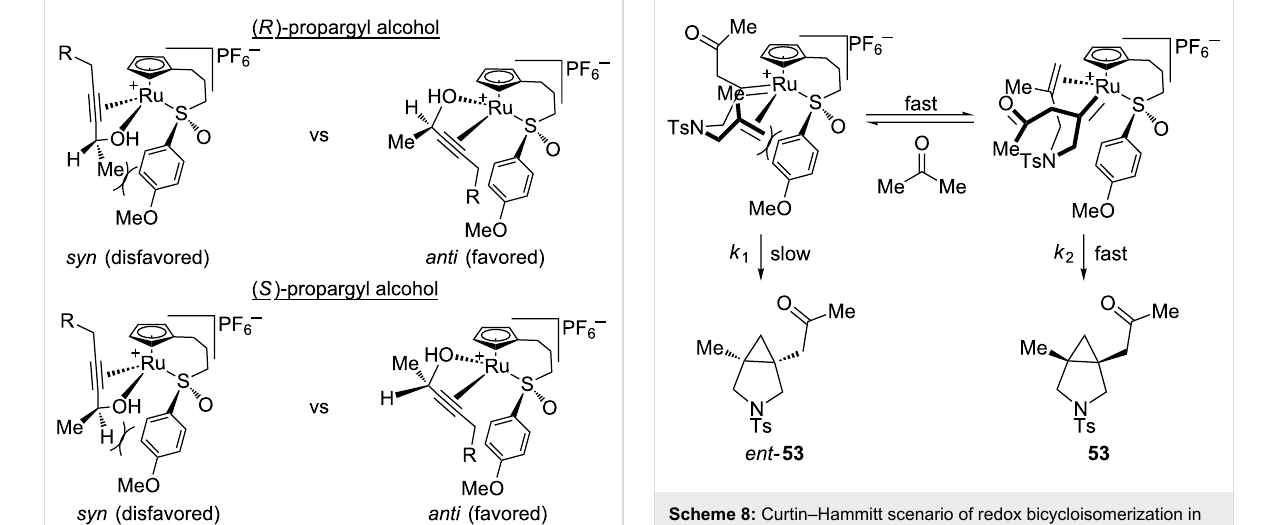
tion can then be transferred back to the substrate following redox isomerization, influencing the overall enantioselectivity of the process. For both the ( R )- and the ( S )-propargyl alcohols, the CpRu-sulfoxide catalyst prefers to place the stereocenter away from the steric bulk of the sulfoxide ( anti